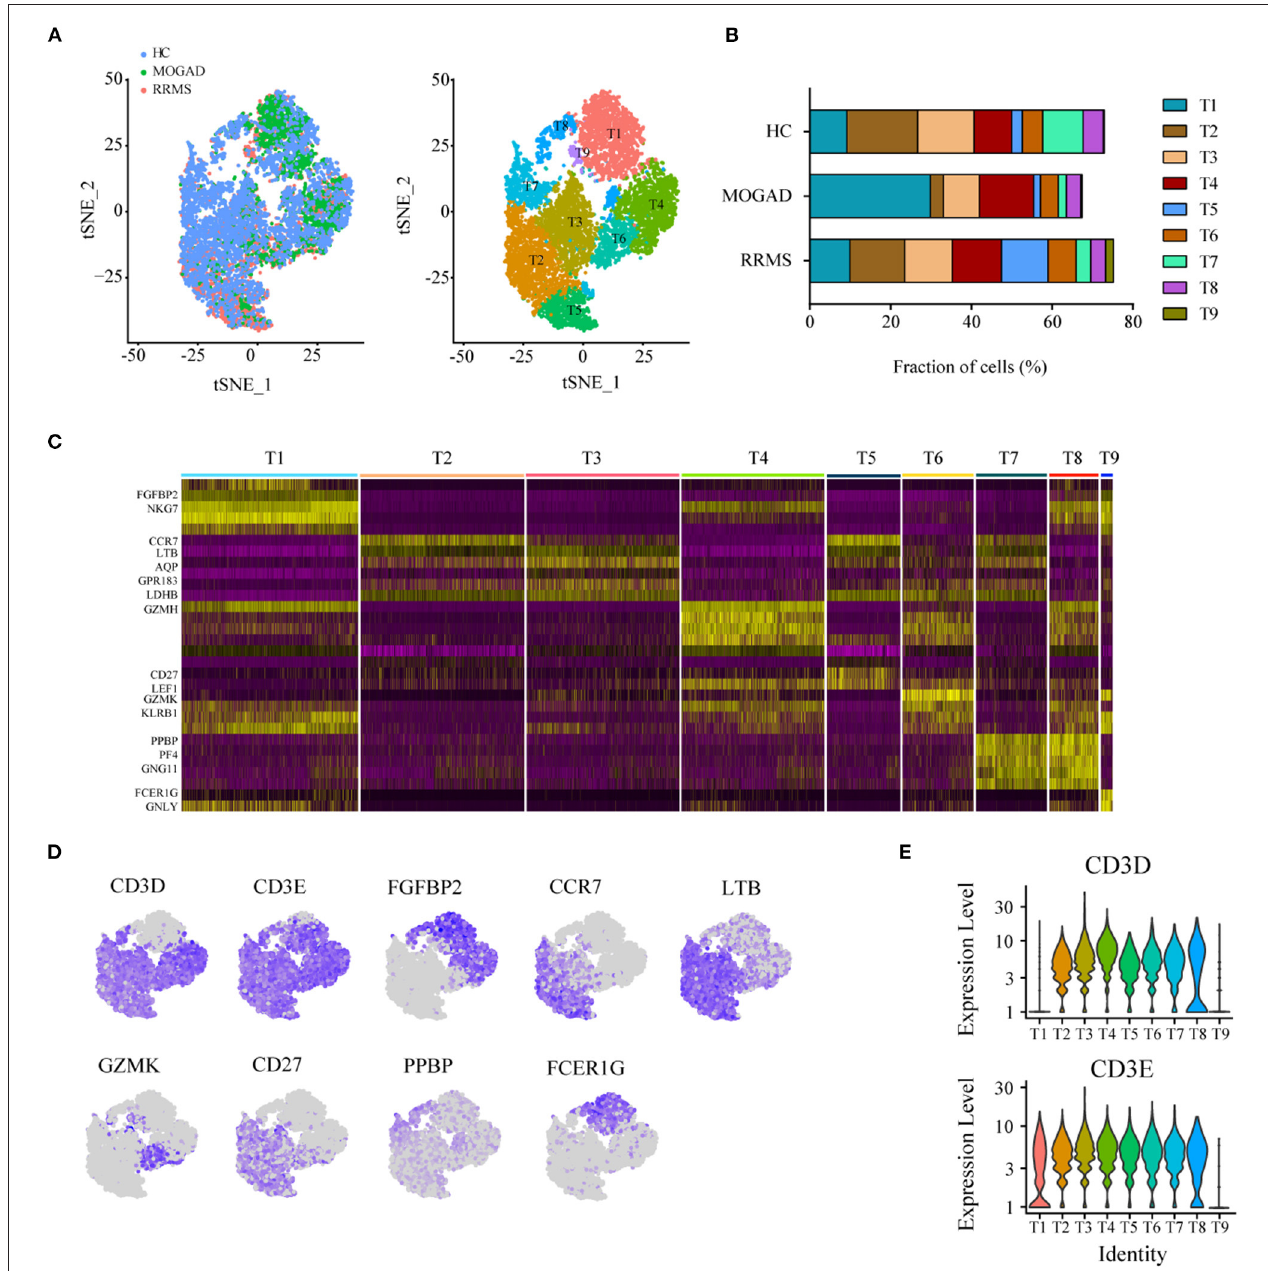
FIGURE 3 | Analysis of T cell clusters from HC, RRMS, and MOGAD. (A) tSNE visualization of T cells from HC, RRMS, and MOGAD. (B) The percentage of cells for T cell subsets in HC, RRMS, and MOGAD. (C) Heatmaps shows the expression of the up- and downregulated markers in T cell subsets. (D) The expression level of marker genes in each T cell type was shown. (E) Violin illustration shows the expression of the marker genes from different T cell types. HC, healthy controls; RRMS, relapsing-remitting multiple sclerosis; MOGAD, myelin oligodendrocyte glycoprotein (MOG) antibody-associated disease; PBMC, peripheral blood mononuclear cell; tSNE, t-Distributed Stochastic Neighbor